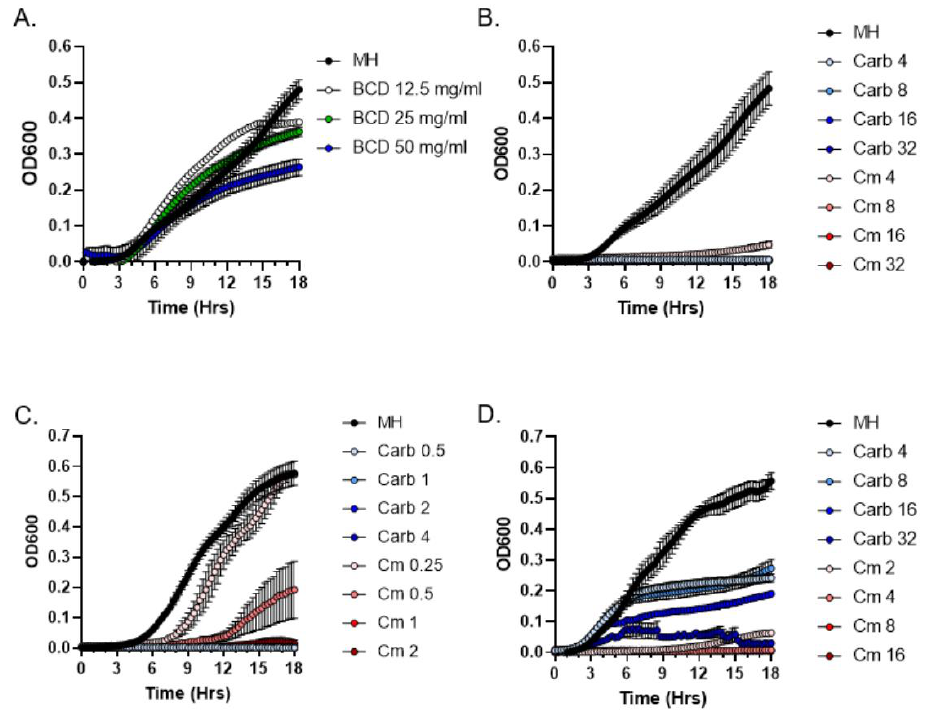
Figure 3. MIC analysis of the effects of BCD medium and antibiotics carbenicillin (Carb) and chloramphenicol (Cm) on bacterial growth . Growth curves of S. aureus ( A , B ), Streptococcus pyogenes ( C ) and Enterococcus faecium ( D ) in the presence of BCD medium ( A ) or in a range of Carb and Cm concentrations in µg/mL ( B – D ) are shown.